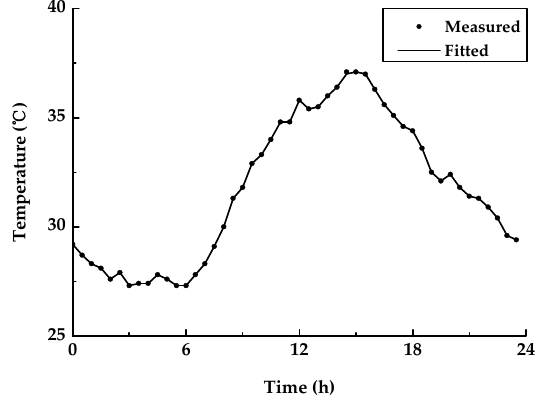
Figure 1. Measured and fitted air temperature on 24 August.